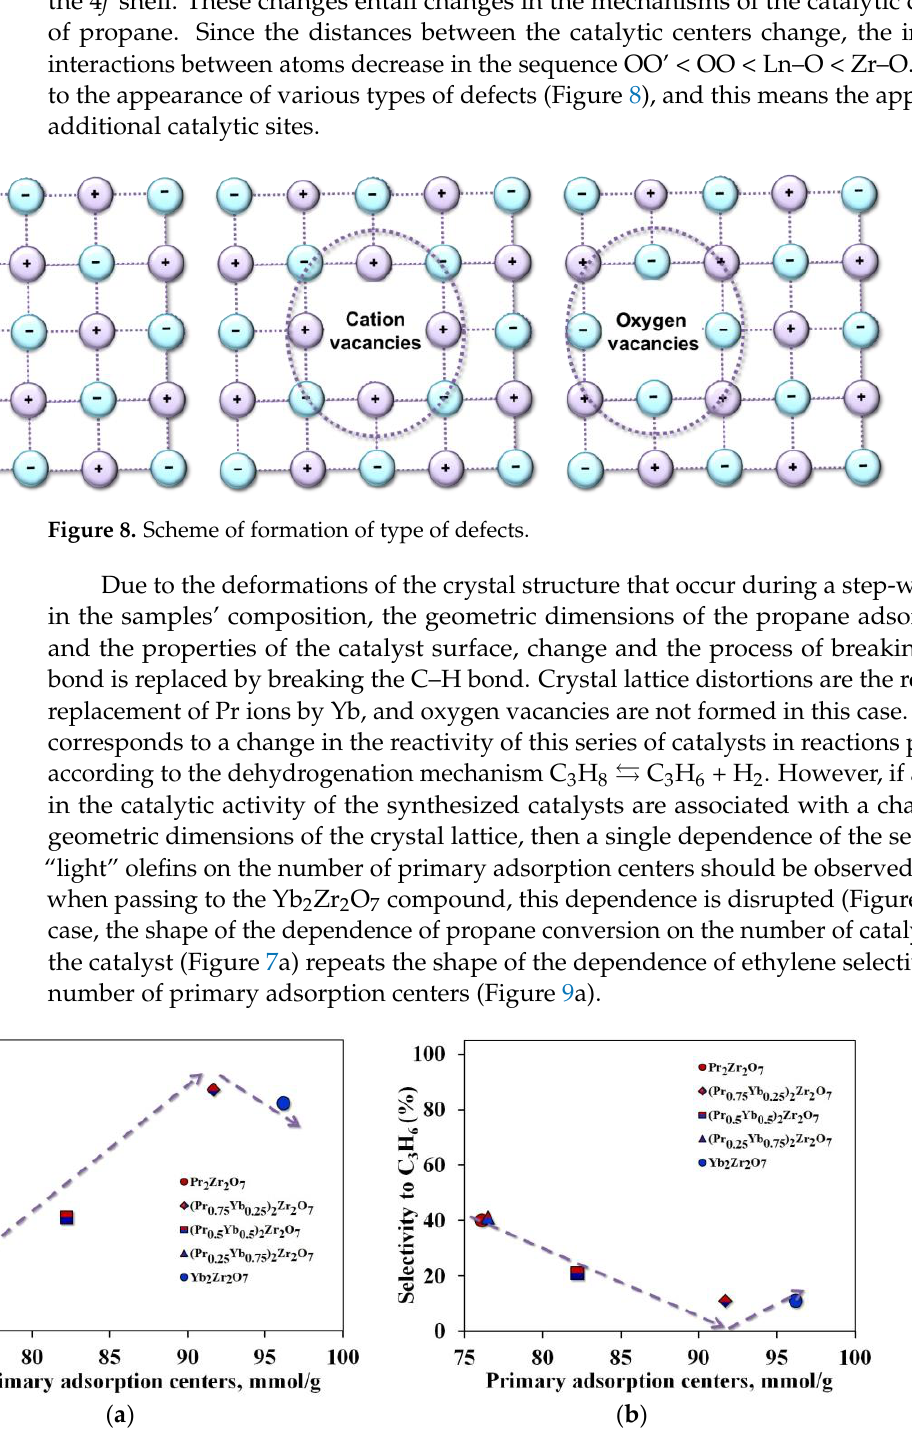
Figure 9. Dependence of selectivity for target products on the number of primary adsorption centers ( a ) — for ethylene, ( b ) — for propylene. ( a )—for ethylene, ( b )—for